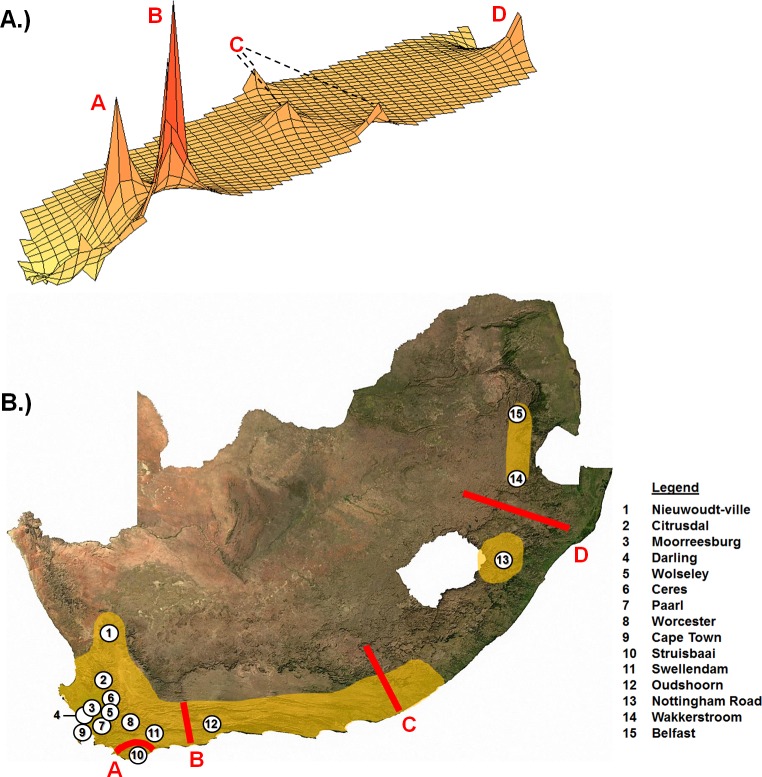
Barriers to gene-flow across the distribution of G. capensis.A) The genetic landscape (derived from the interpolation analysis in Alleles In Space) of G. capensis across the sampled distribution. Peaks on the landscape represent areas that are probable barriers to gene-flow (labelled A-D) with B) showing the location of these barriers on the distribution map of G. capensis.